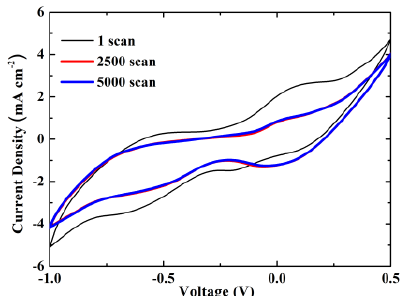
Figure 4. Cyclic voltammograms of ZnO/3D-printed graphene for 10 mV s −1 and a number of scans up to 5000.